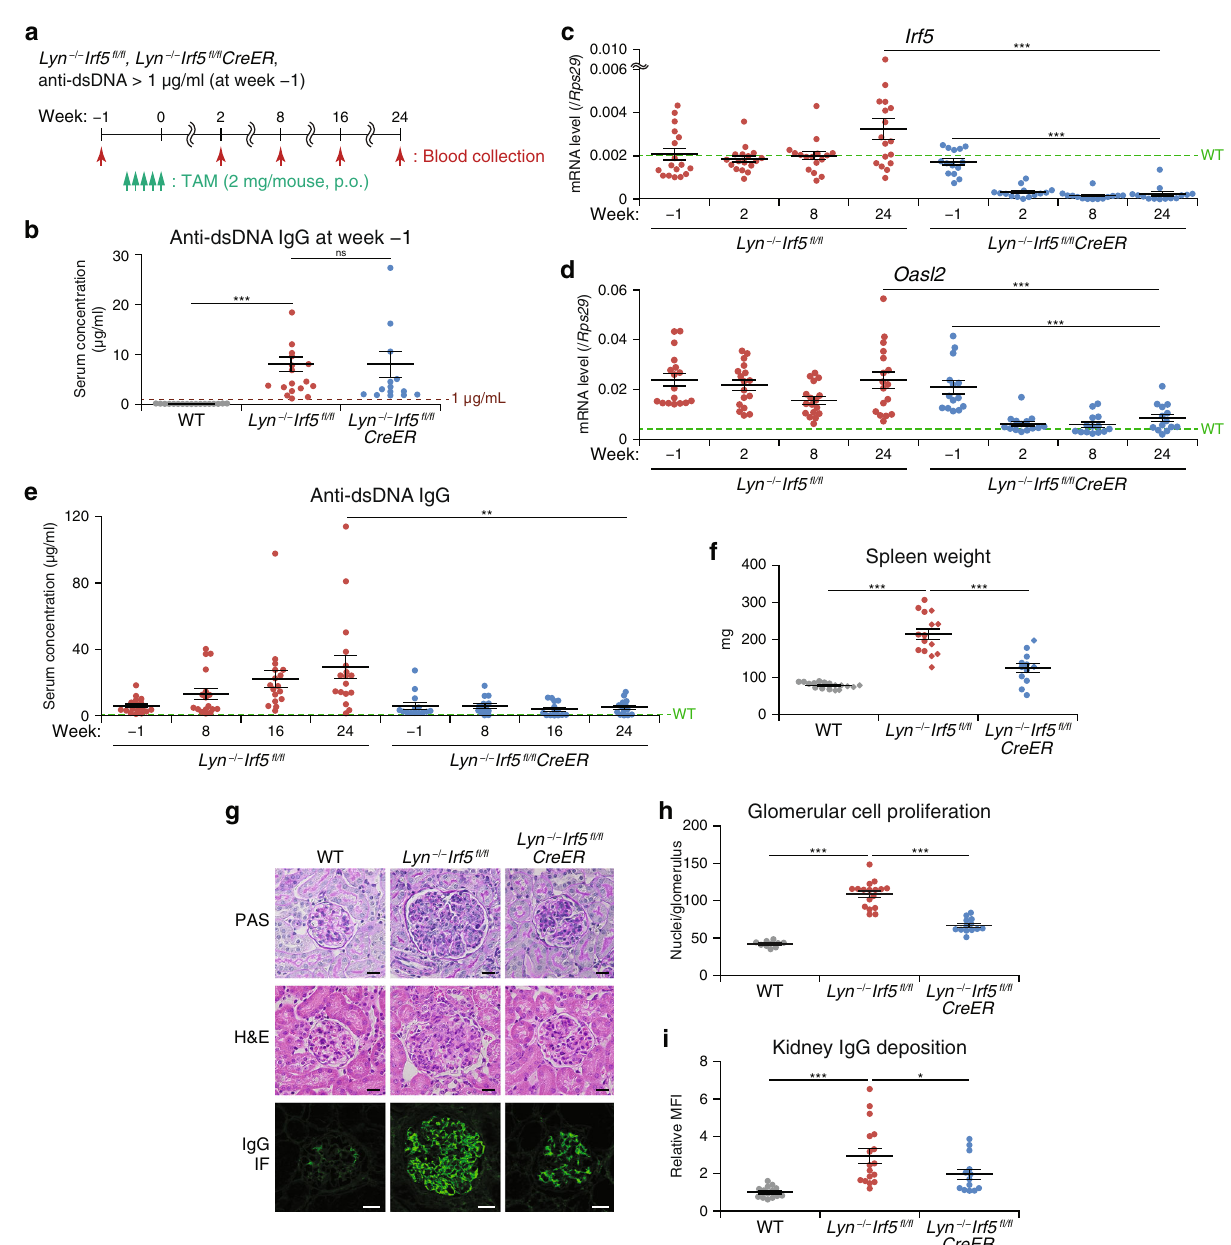
Fig. 3 Therapeutic effect of Irf5 ablation on pre-existing mouse SLE-like disease. a The scheme of the IRF5 cKO experiment; p.o. per os. b Concentration of serum anti-dsDNA IgG in WT ( n = 17), Lyn − / − Irf5 fl / fl ( n = 17), and Lyn − / − Irf5 fl / fl CreER ( n = 14) female and male mice at 1 week before tamoxifen (TAM) treatment (11 – 23 weeks of age). c , d Irf5 and ISG expression. Irf5 ( c ) and Oasl2 ( d ) mRNA levels in peripheral blood from mice in b at the indicated time points were analyzed by RT-qPCR. e Autoantibody formation. Serum anti-dsDNA IgG concentrations in mice in b at the indicated time points were measured by ELISA. f Spleen weight of WT ( n = 17), Lyn − / − Irf5 fl / fl ( n = 15), and Lyn − / − Irf5 fl / fl CreER ( n = 12) mice at 24 – 28 weeks after TAM treatment (40 – 51 weeks of age). The circles and diamonds denote the female and male mice, respectively. g – i Kidney pathology and IgG deposition analyses as in Fig. 2d – f. WT ( n = 10 in h and 14 in i ), Lyn − / − Irf5 fl / fl ( n = 17), and Lyn − / − Irf5 fl / fl CreER ( n = 13) mice at age 40 – 51 weeks were studied. Scale bars represent 20 μ m. Horizontal bars ( b – f , h , i ) indicate mean ± SEM. Dashed lines ( b – e ) denote the mean of WT mouse data. Data were compiled from seven independent experiments. * P < 0.05, ** P < 0.01, *** P < 0.001 (two-sided Student ’ s t test in b , e , f ; two-sided Welch ’ s t test in h , i ; two-sided Student ’ s t test for a comparison between genotypes or the two-sided paired t test for a comparison within the same genotype in c , d